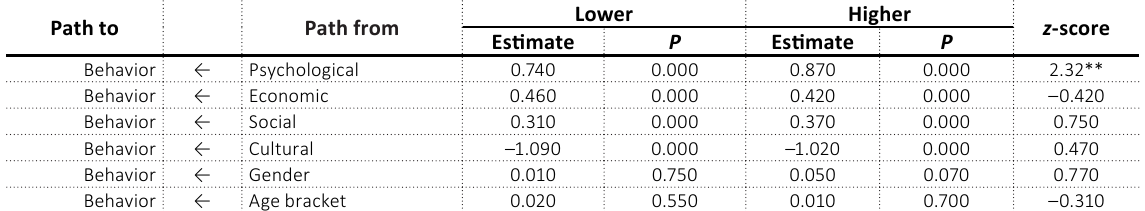
Table 6. Income Path to Path from